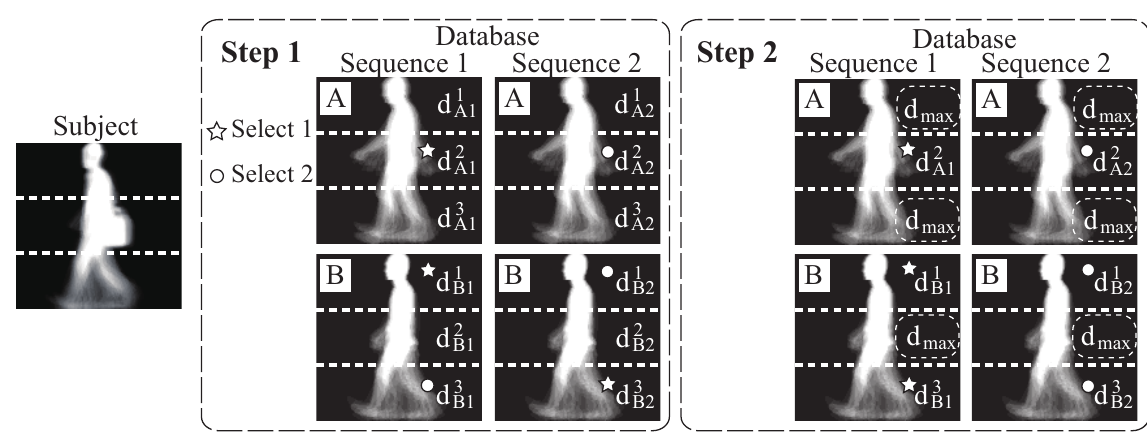
Figure 3. Estimation of matching